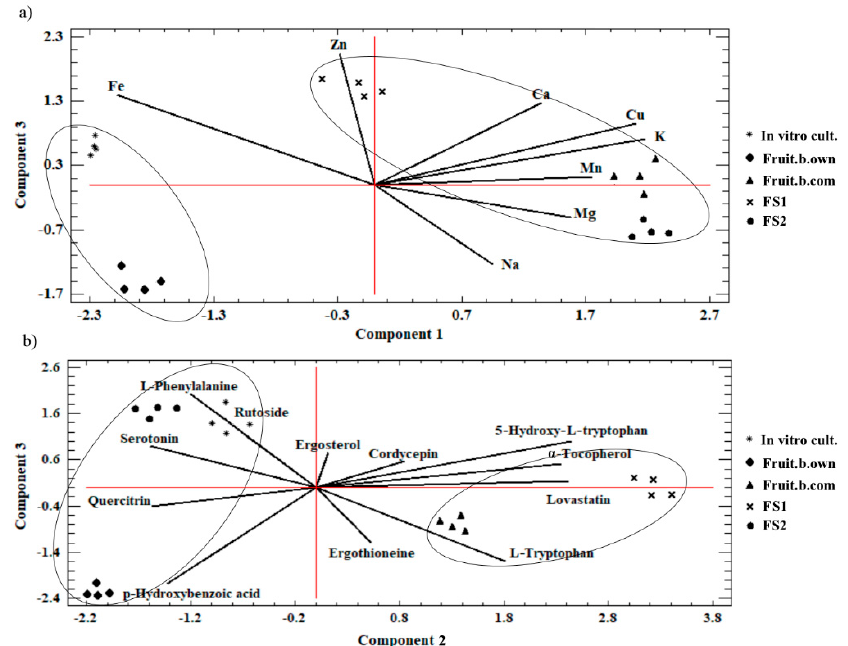
Figure 3. Graph showing the correlation between the analyzed C. militaris samples in relation to ( a ) the content of bioelements and ( b ) the content of organic compounds determined in them.